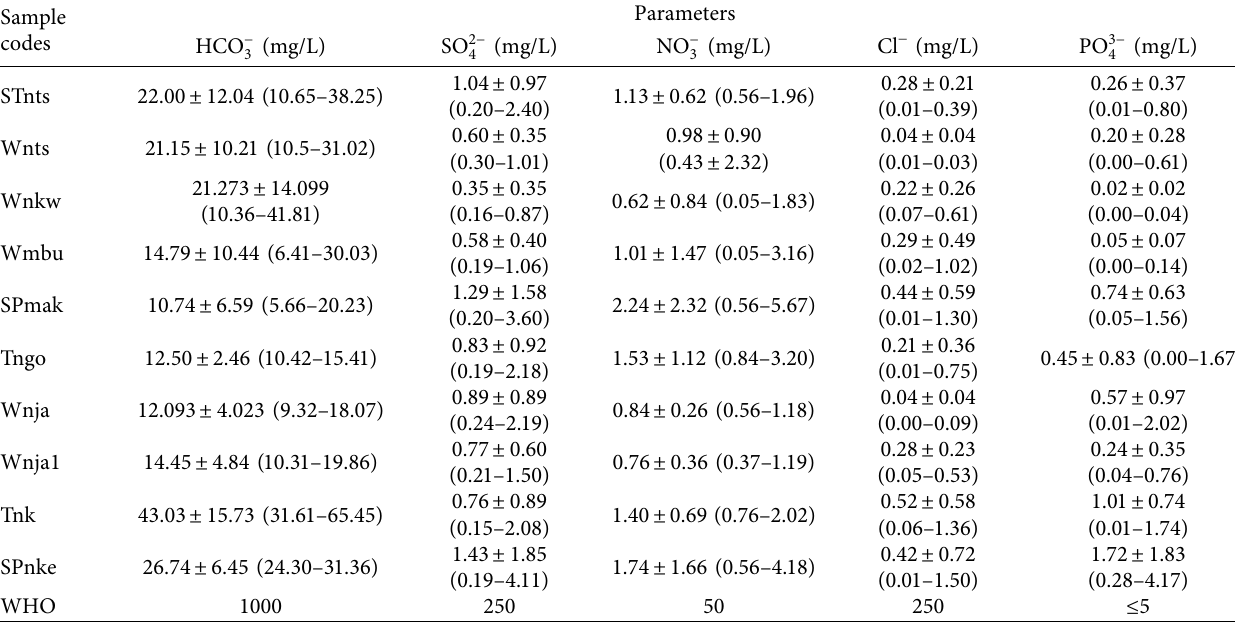
Table 4: Results of analysed anions in the samples from ten water sources in Bangolan within the study period.